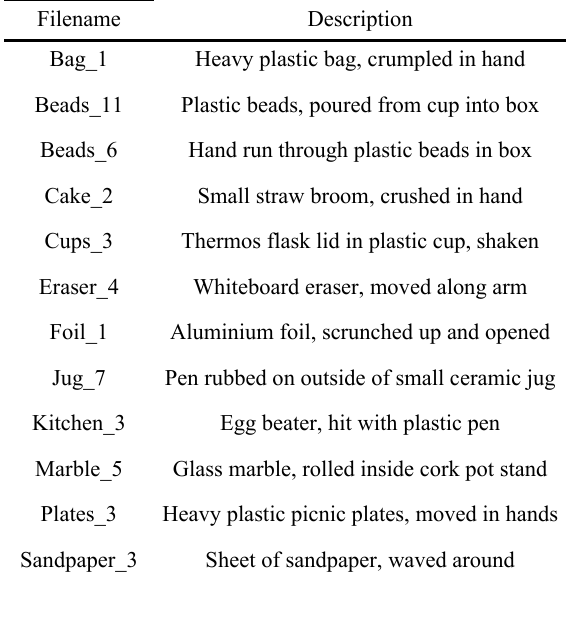
A description of the auditory stimuli used in the experiment. The name of the original sound file is given, along with a short description of the sound